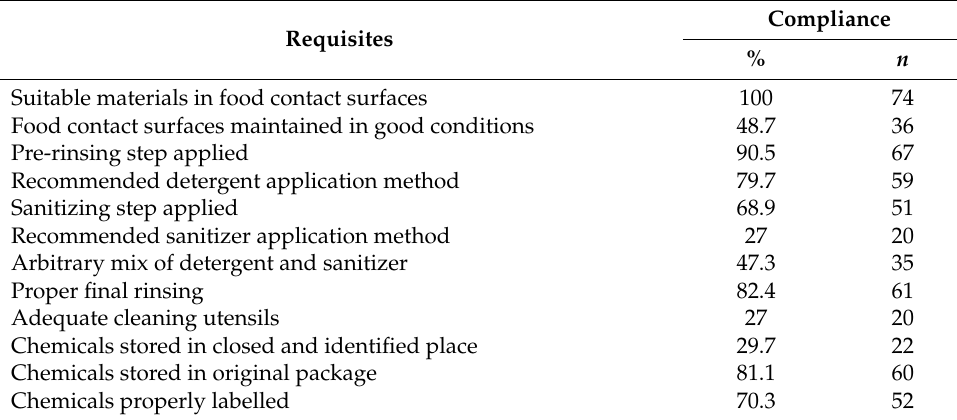
Table 5. Food contact surfaces hygiene practices compliance